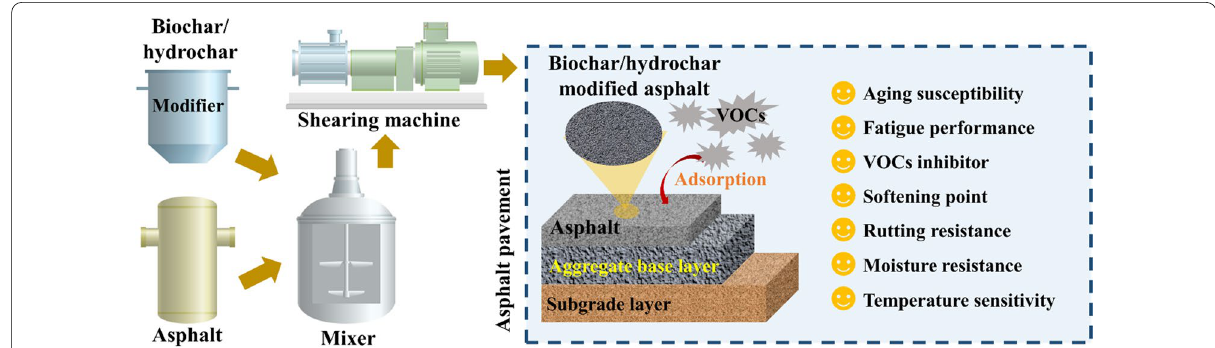
Fig. 4 Biochar as a modifier for asphalt